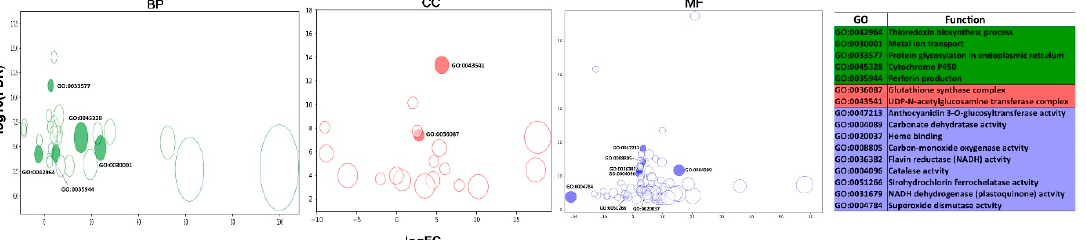
Figure 4. A bubble plot of the annotated differentially expressed genes (DEGs) gene expressions and gene ontology (GO) classification. The results summarized in three main categories: Biological process (BP), cellular component (CC), and molecular function (MF).